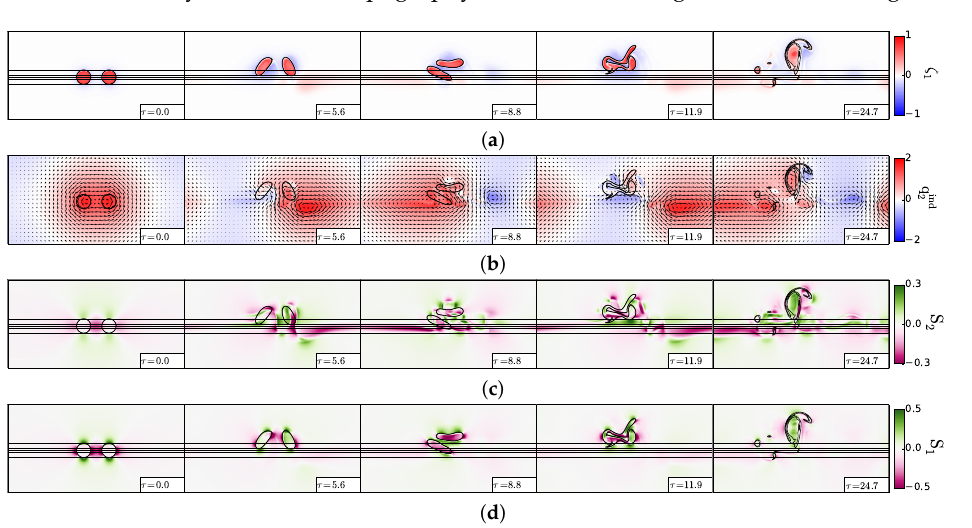
Figure 15. Filamentation and asymmetric merger of two cyclones, case d / R = 3.6, γ R = 2, d c / R = 0. ( a ) Upper layer relative vorticity (Equation (3)); ( b ) lower layer “equivalent barotropic” potential vorticity and velocity field (Equations (4) and (11)); ( c ) lower layer velocity shear (Equation (5)); ( d ) upper layer velocity shear (Equation (5)). In (a,c,d), the black contours indicate the topographic slope (Equation (12); straight lines) and the upper layer vorticity contours showing the two vortex